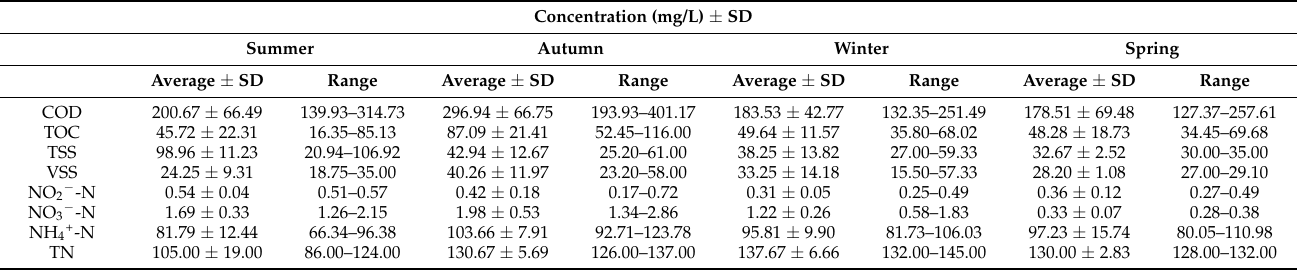
Table 2. Physicochemical characterization of the